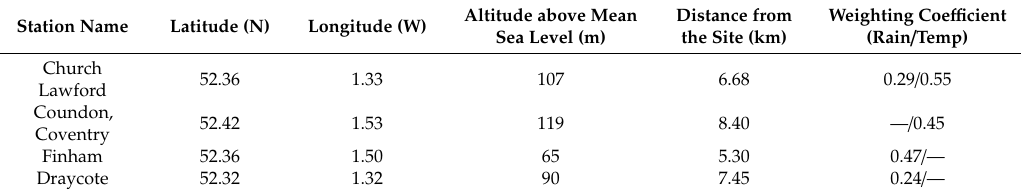
Table 4. Weather stations utilised in the study for the monitoring period of this research: 21